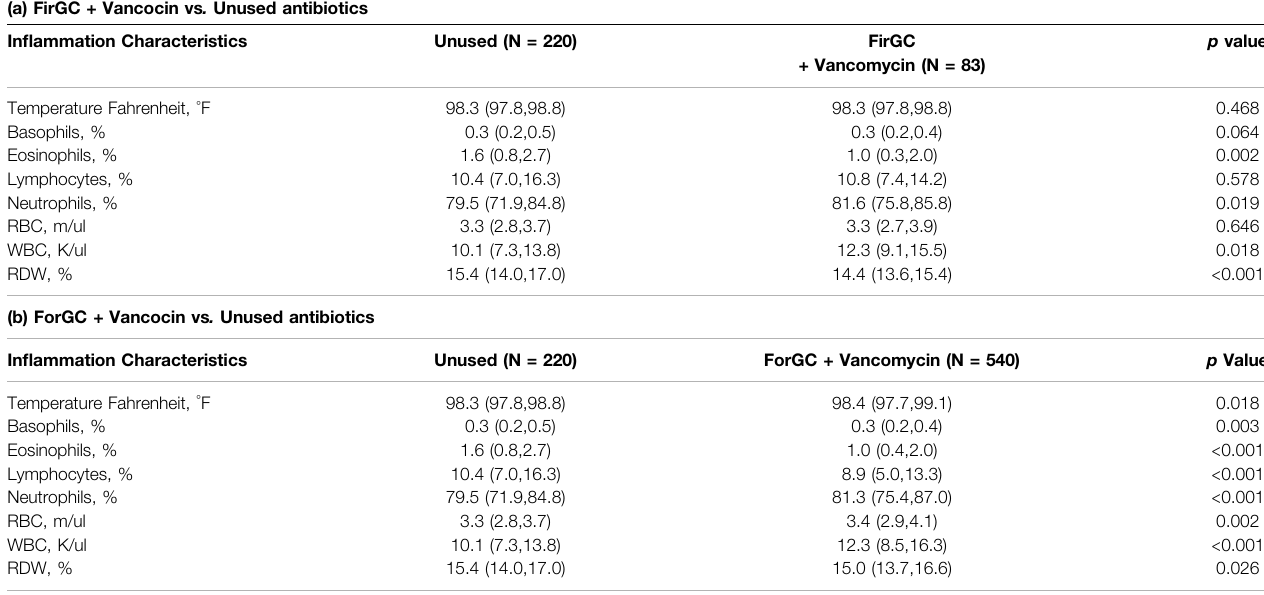
TABLE2| Comparisonofdifferencesinin fl ammatoryrelatedcharacteristics.(a)FirGC+Vancomycinvs . Unusedantibiotics;(b)ForGC+Vancomycinvs . Unusedantibiotics. (a) FirGC + Vancocin vs . Unused